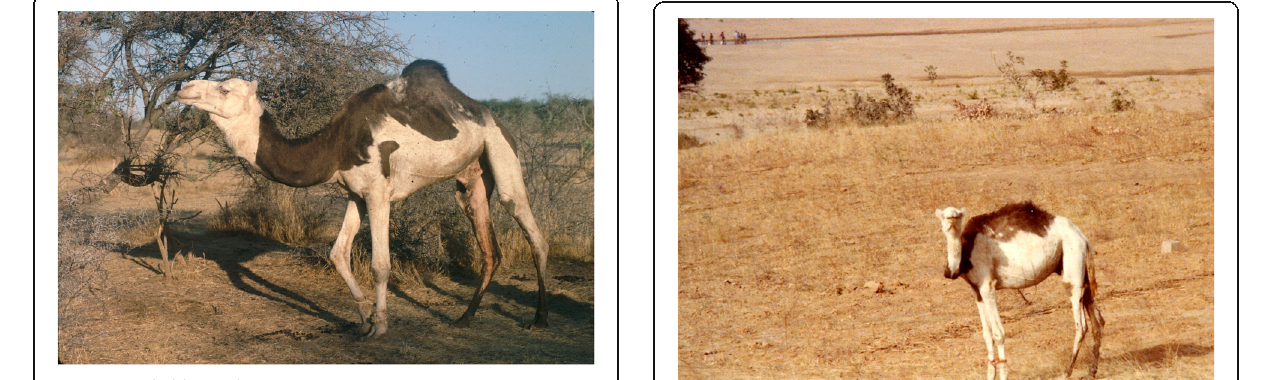
Figure 9 Piebald camel in Niger in 1994 (B.